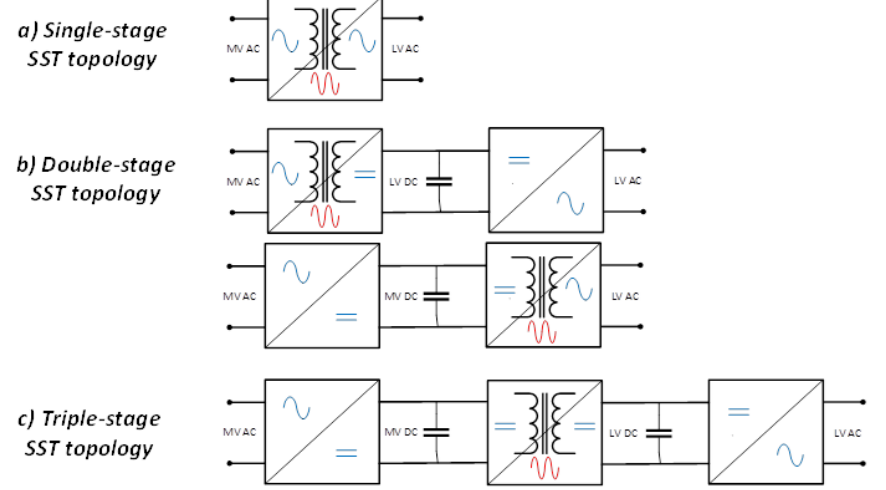
Figure 3. Solid-state transformer topology classification. ( a ) Single-Stage SST topology, ( b ) Double- Stage SST topology, ( c ) Triple-Stage SST topology.